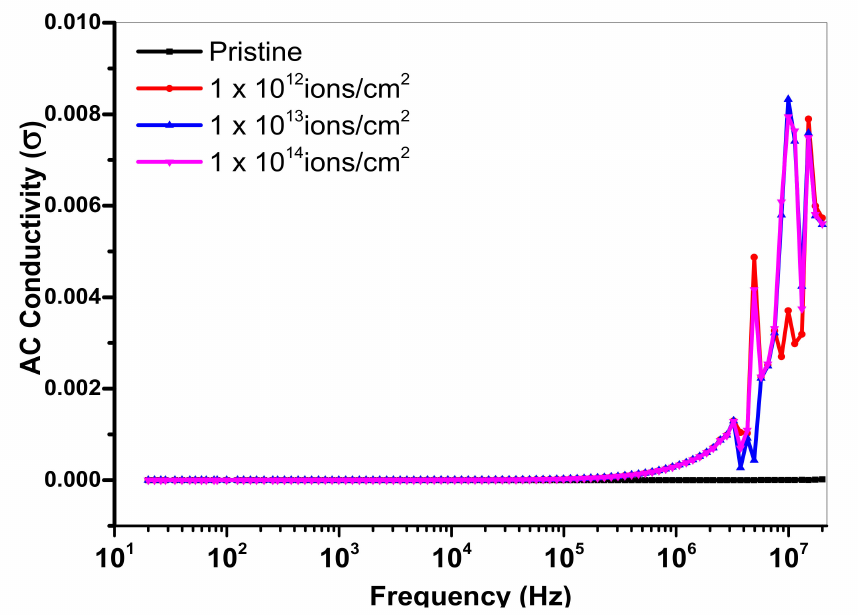
Figure 13. Variation of AC conductivity with different doses of Cu